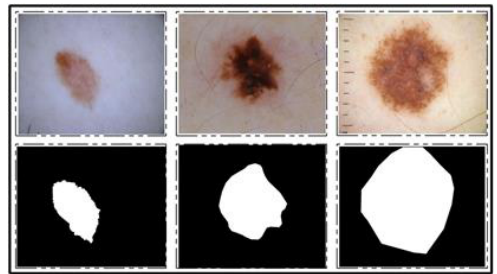
Figure 3. Sample images for lesion segmentation task from ISIC 2018 challenge dataset [26].